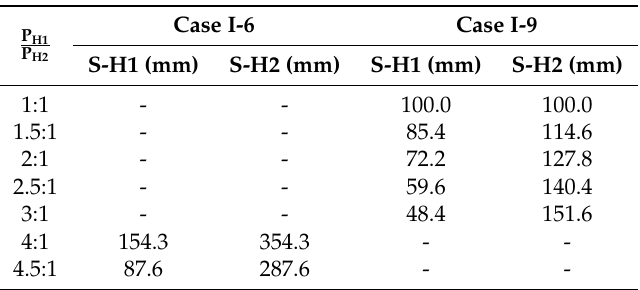
Table 4. Simulation Results of the Proposed Empirical Circuit